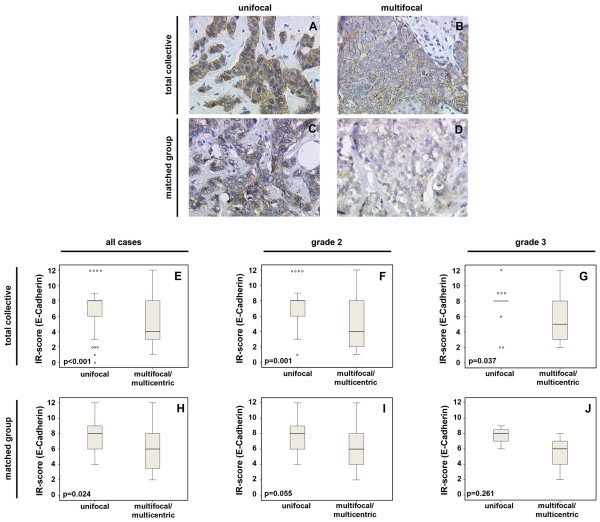
E-cadherin expression in the total collective (A, B) and in the matched group (C, D) of unifocal (A, C) and multicentric/multifocal (B, D) breast cancer; magnification 25× lens. Semiquantitative evaluation of staining results (IR score) is presented in box plots (E-G) for the total collective and in the box plots (H-J) for the matched group with respect to differences between G2 and G3-tumors. The boxes represent the range between the 25th and 75th percentiles with a horizontal line at the median. The bars delineate the 5th and 95th percentiles. The circles indicate values more than 1.5 box lengths away from the median.